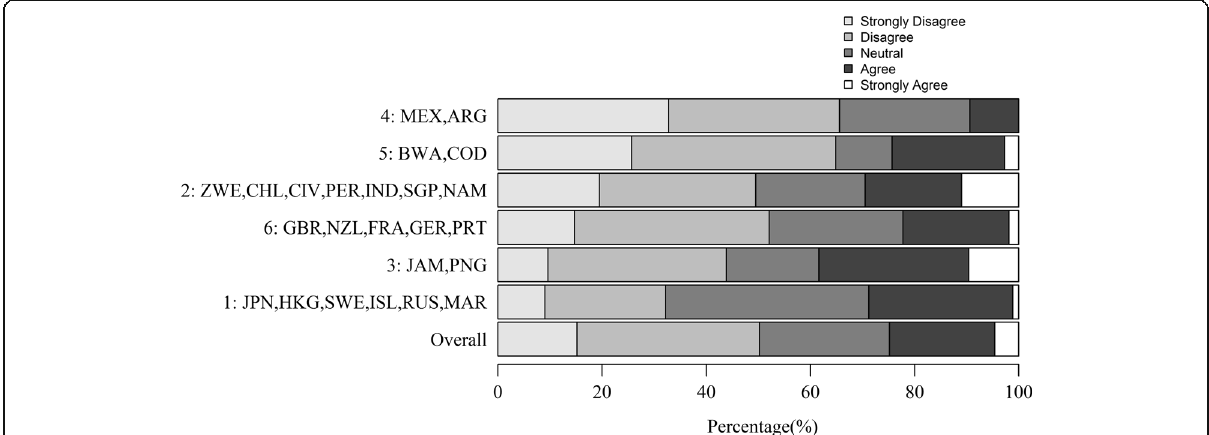
Fig. 6 Overall percentage response (%) and response by surface experience cluster (ordered from highest to lowest percentage of ‘ Strongly Disagree ’ ) to the statement ‘ I am less likely to get tired playing on artificial turf (AT) compared to a natural turf (NT) pitch